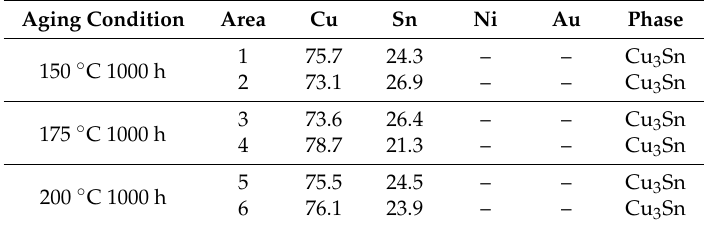
Table 3. Chemical composition (at.%) in the marked areas in Figure 10 measured by EDX spectroscopy.